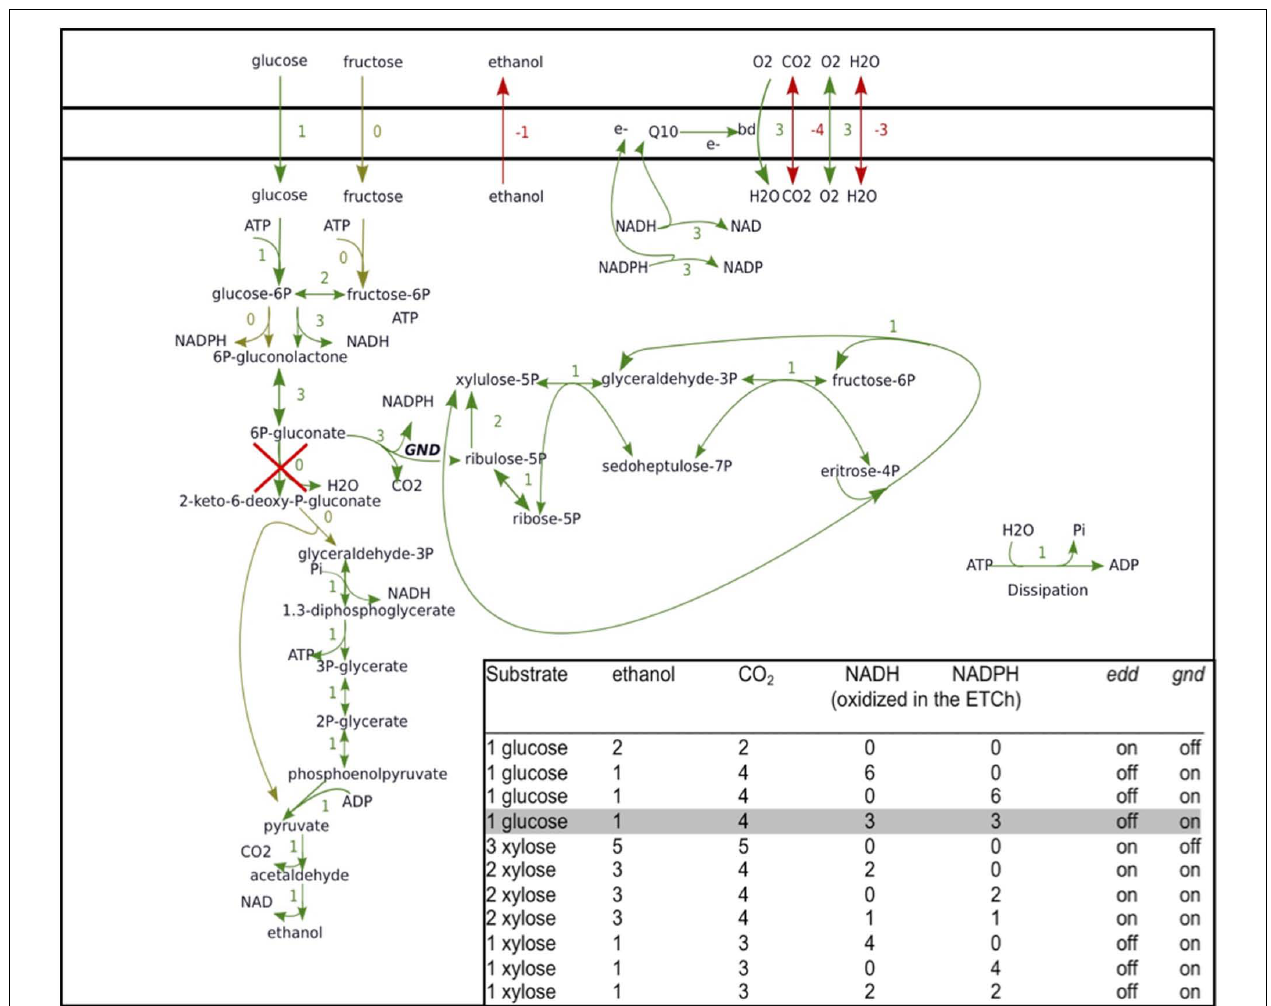
FIGURE 2 | Elementary flux modes of aerobic glucose and xylose catabolism for a strain with engineered pentose phosphate pathway enzymes. Elementary flux mode for catabolism of glucose in cells with knocked-out edd and overexpressed heterologous gnd via the Entner–Doudoroff and pentose phosphate pathway, involving both NADH- and NADPH-oxidizing activity of the respiratory chain, is shown. ScrumPy